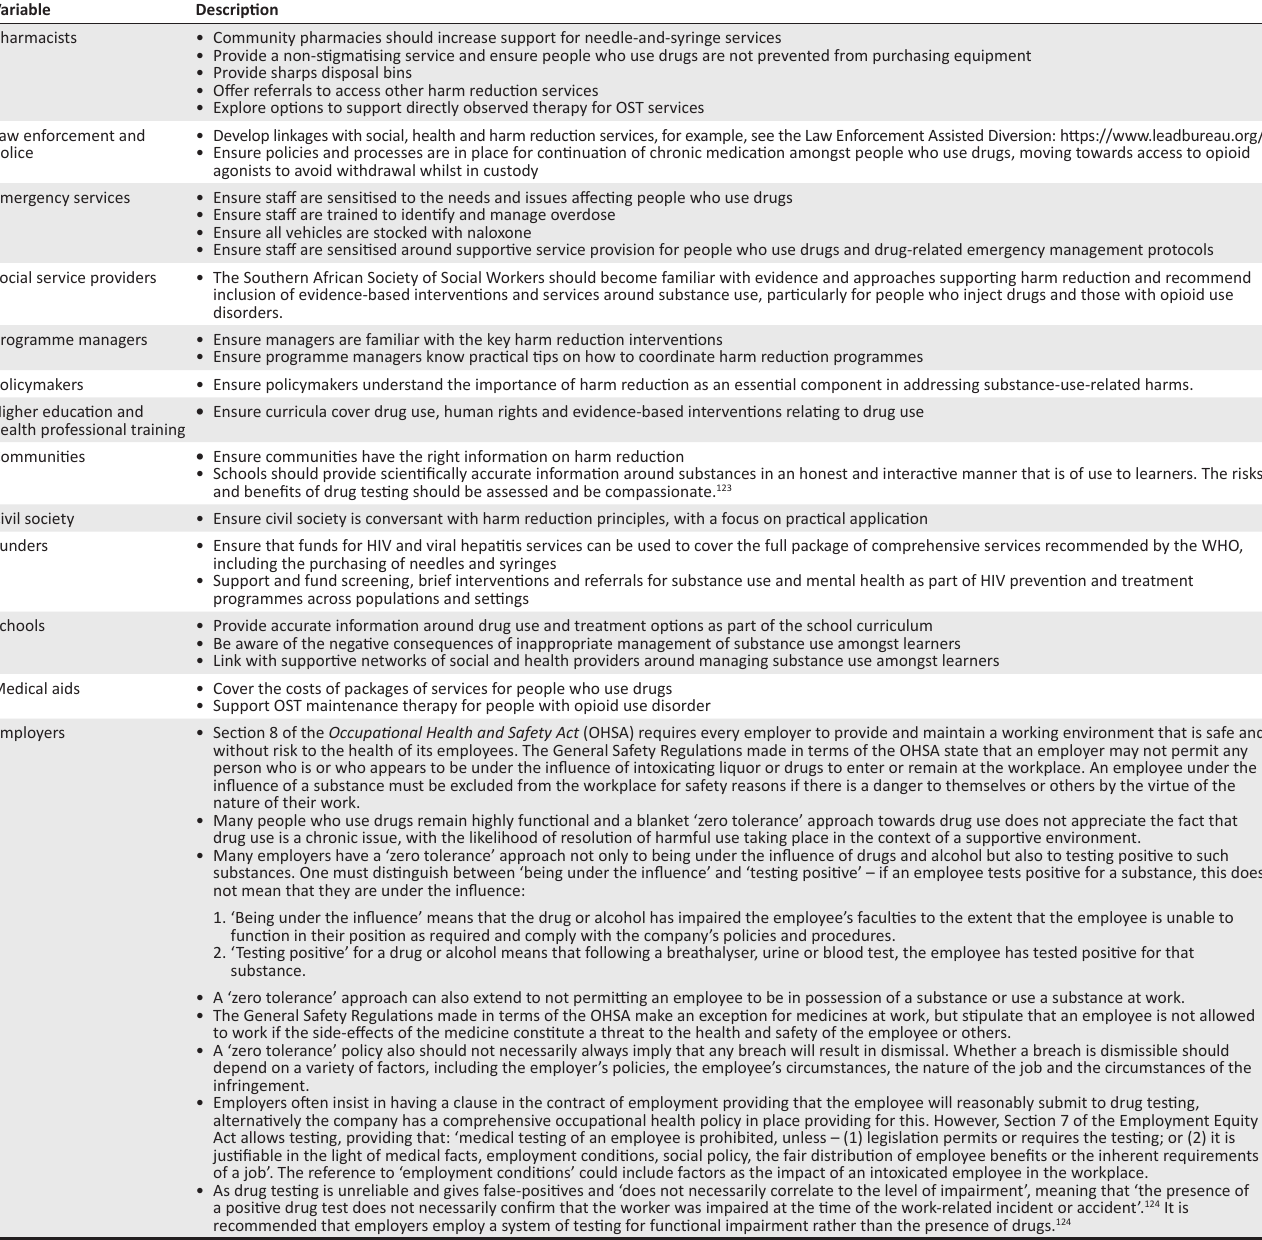
TABLE 29: Summary of harm reduction recommendations per